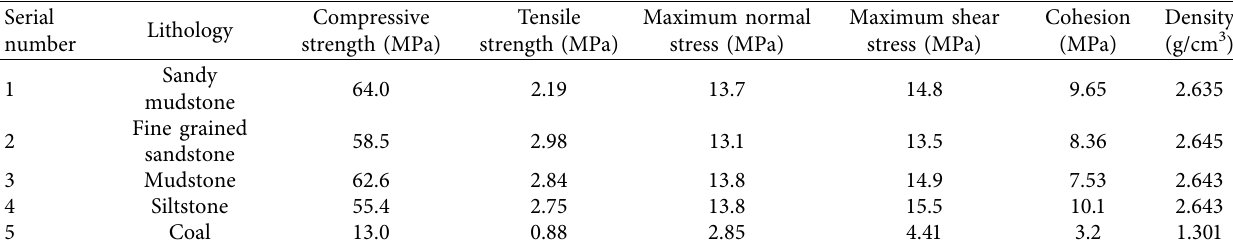
Table 2: List of physical and mechanical properties of coal and